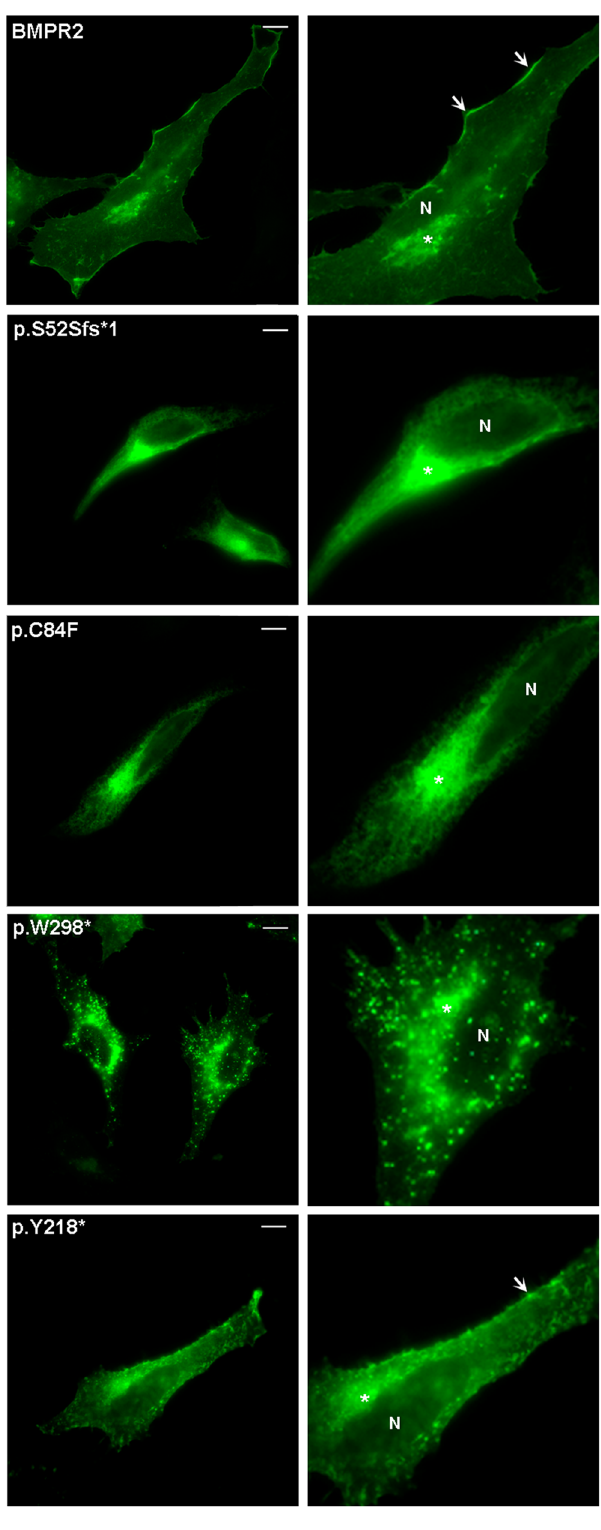
Figure 5. Representative photomicrograph showing subcellular localization of the BMPR2 wild-type and those mutants which pattern of expression is altered. All these constructs are GFP-tagged at the C-terminus. After 24 h post-transfection, HELA cells were fixed and mounted in Fluoromount-F. Images were visualized using a Leica TCS SP2 confocal system. Arrows indicates plasma membrane location. Asterisk indicates perinuclear region. The scale bar is 10 μ